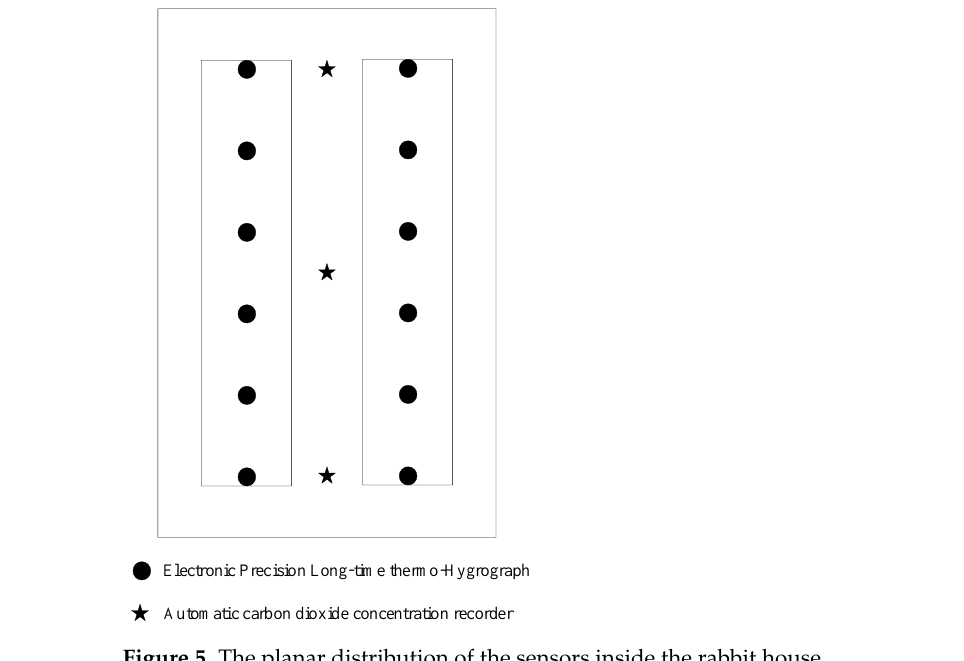
Figure 5. The planar distribution of the sensors inside the rabbit house.